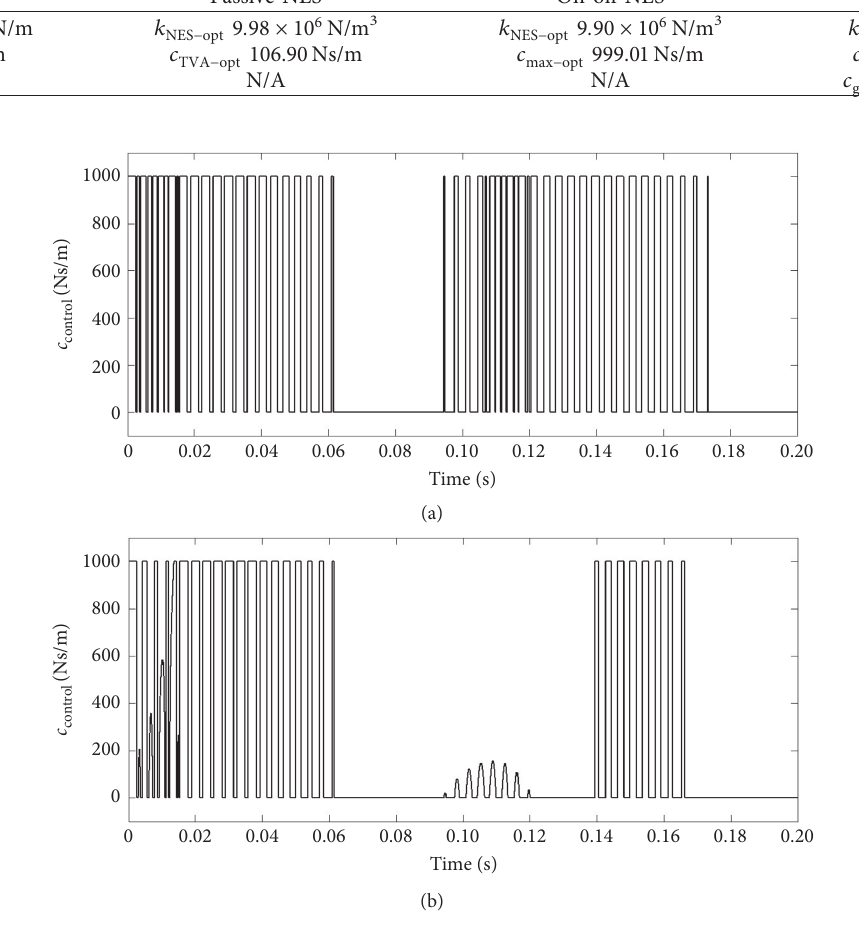
Figure 8: (a) Semiactive damping of on-off NES. (b) Semiactive damping of continuous NES.